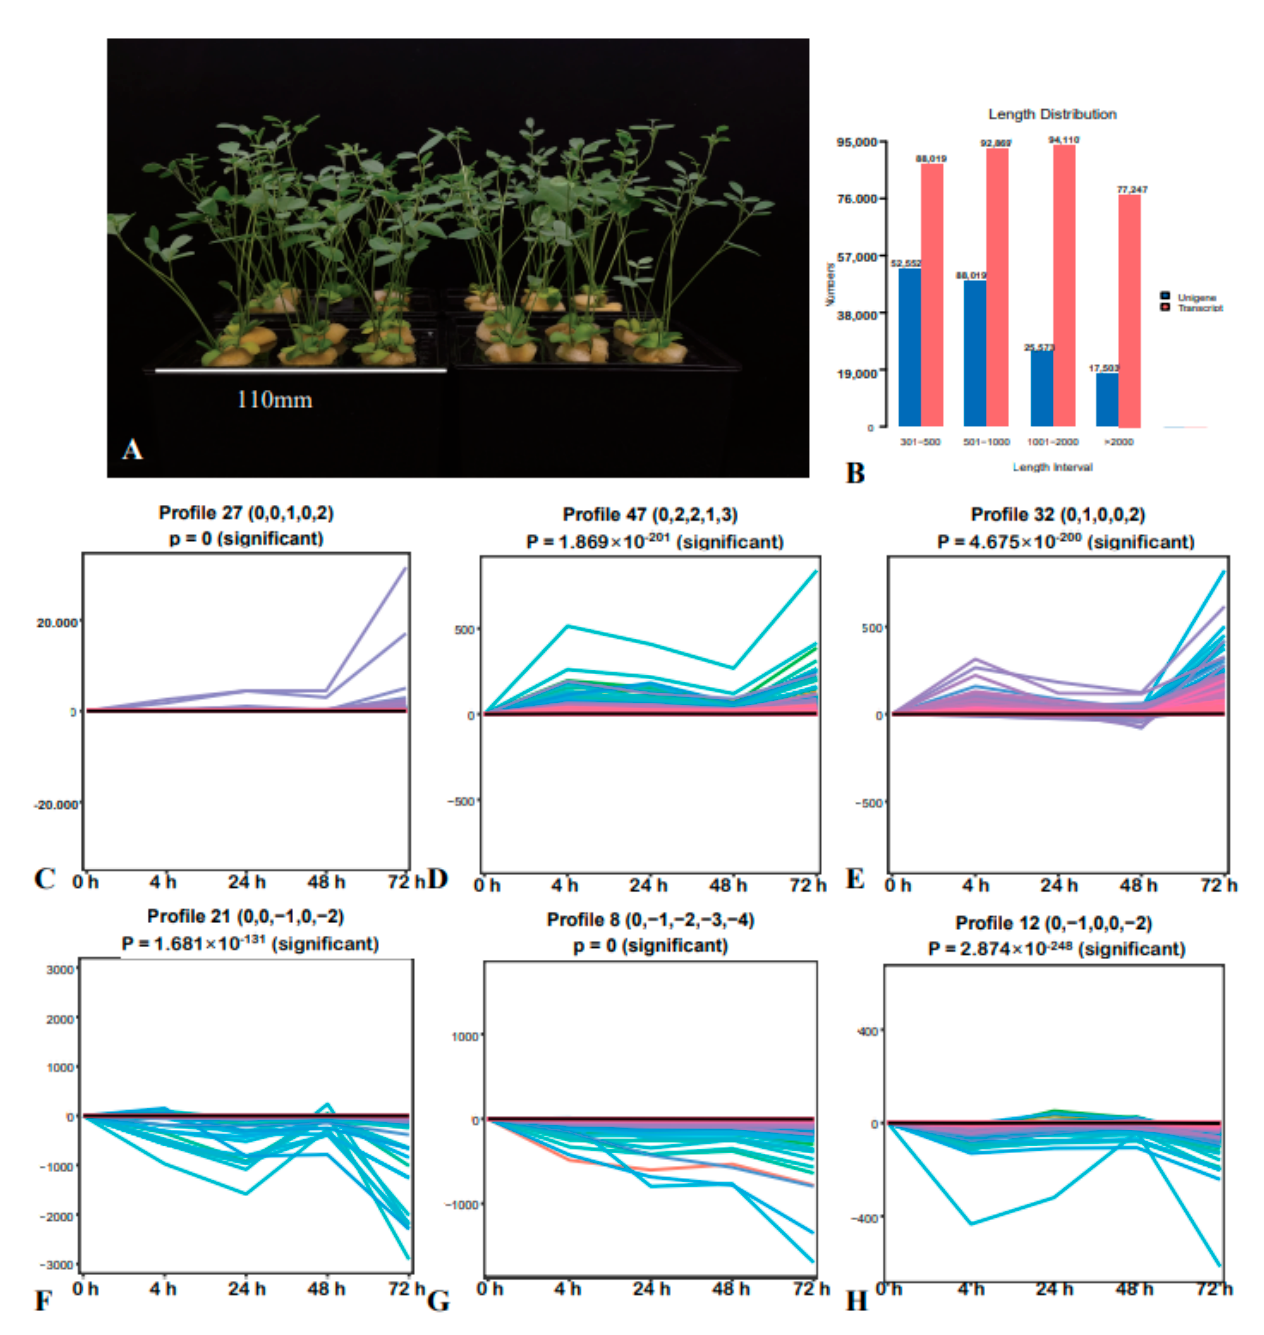
Figure 1. Analysis of the expression trend of differentially expressed genes. The horizontal axis represents the salt treatment time (0, 4, 24, 48, and 72 h). ( A ) Four-year-old Sophora alopecuroides hydroponic culture (1/8*Hoagland nutrient solution). ( B ) Transcript/unigene sequence length distribution (the abscissa is the transcript/unigene length interval, the ordinate is the number of transcripts/unigene). ( C ) Expression trend was 0.0, 0.0, 1.0, 0.0, and 2.0, with a total of 1984 differentially expressed genes (DEGs; 22.94%). ( D ) Expression trend was 0.0, 2.0, 2.0, 1.0, and 3.0, with a total of 481 DEGs (5.56%). ( E ) Expression trend was 0.0, 1.0, 0.0, 0.0, and 2.0, with a total of 1283 DEGs (14.83%). ( F ) Expression trend was 0.0, 0.0, − 1.0, 0.0, and − 2.0, with a total of 355 DEGs (4.10%). ( G ) Expression trend was 0.0, − 1.0, − 2.0, − 3.0, and − 4.0, with a total of 725 DEGs (8.38%). ( H ) Expression trend was 0.0, − 1.0, 0.0, 0.0, and − 2.0, with a total of 524 DEGs (6.06%).